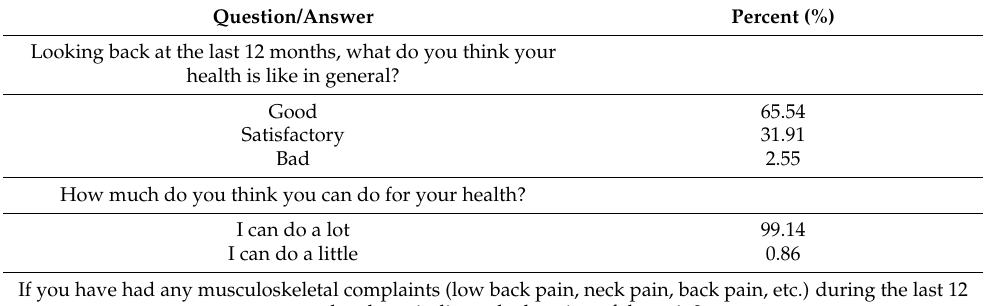
Table 3. The distribution of participants by percentage among specific answer categories for multiple- choice questions in preIQ ( n =